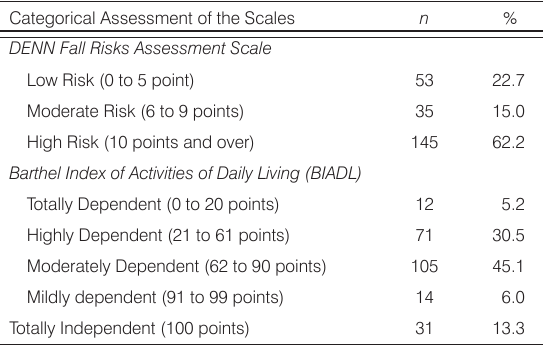
Table 2. The participants’ DENN Fall Risks Assessment Scale and Barthel Index of Activities of Daily Living